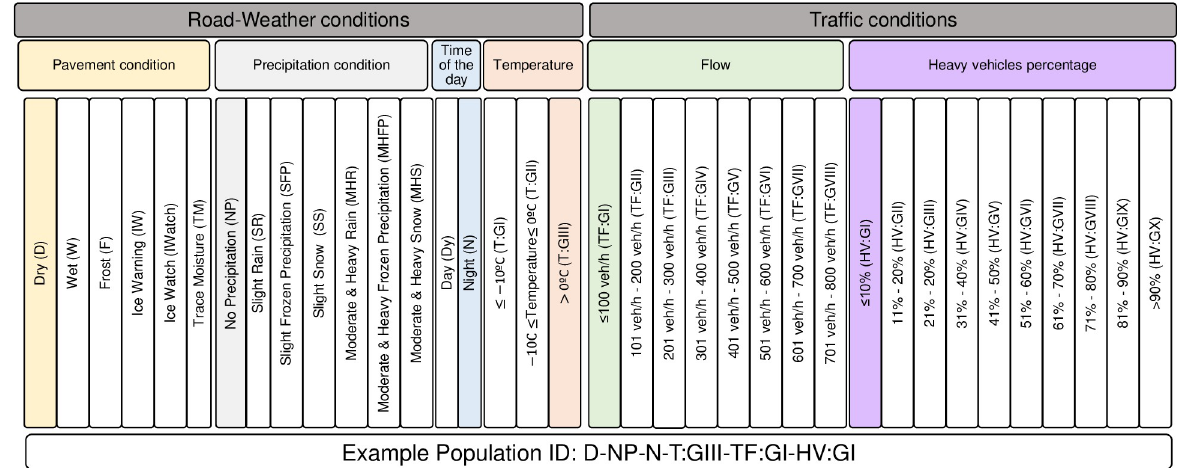
Fig 5. Categories of road-weather and traffic conditions to identify